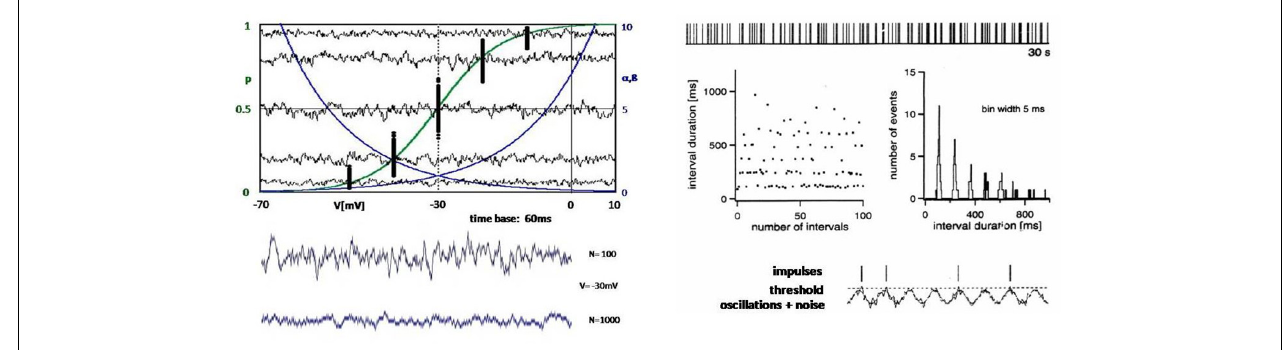
FIGURE 3 | Left: Computer simulations of the opening states of ion channels with randomly introduced variability (according to the left-hand diagrams in Figure 2 ), which manifests itself as noise over time. The upper diagram again shows the exponential transition functions α and β (blue) and the resulting Boltzmann function p (green). The black dots are the opening probabilities averaged over 60 ms according to the points in Figure 3 (top left), but are now determined for repeated passes with a few potentials. In addition, the fluctuations of the opening probabilities are shown as a sum of 100 ion channels over the period of 60 ms. The lower diagram shows another curve of the fluctuations at –30 mV with 100 ion channels and at a 10-fold increase to 1,000 channels. Right: Pulse sequence, interspike intervals, and interval histogram to illustrate a neuronal pulse pattern whose structure implies that the action potentials are generated by intrinsic oscillations with functionally decisive participation of random processes (noise) (Braun et al.,